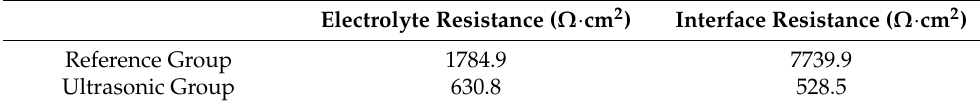
Table 2. Electrolyte resistance and interface resistance of the cathode symmetric batteries.